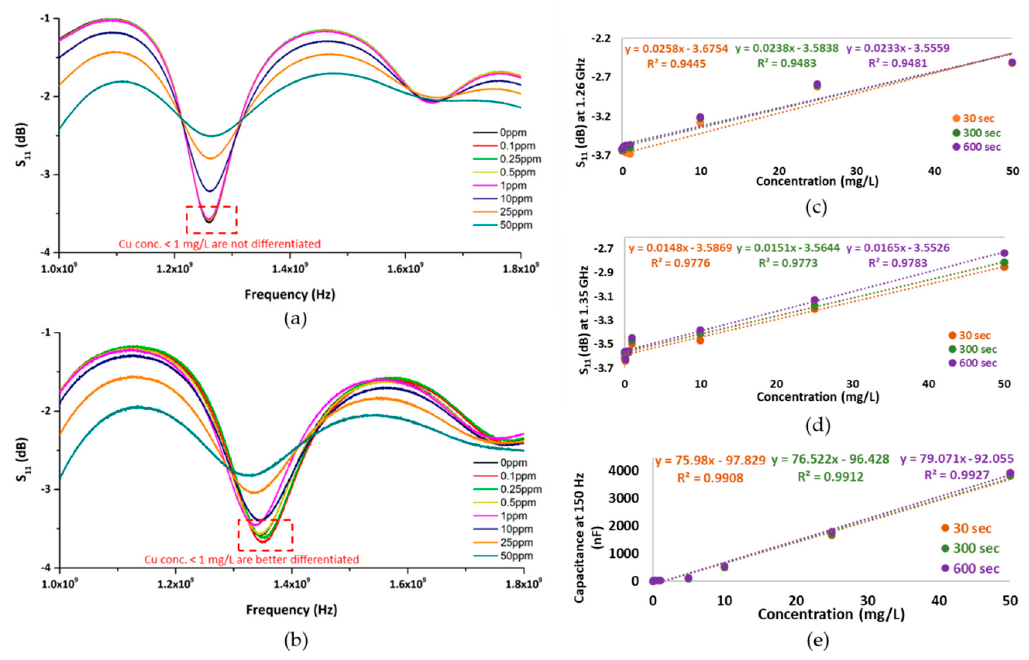
Figure 3. S 11 response (1–1.8 GHz) at 10 min for various Cu concentrations in water measured with ( a ) uncoated sensors and ( b ) f-EM sensors. Their linear correlations at the respective peaks (1.26 GHz and 1.35 GHz) at 30, 300 and 600 s of interaction are shown in ( c , d ); the high linear correlation (R 2 > 0.99) between capacitance and Cu samples using L-Cy-Ch-Ru based coatings screen-printed on Ag IDE is shown in ( e